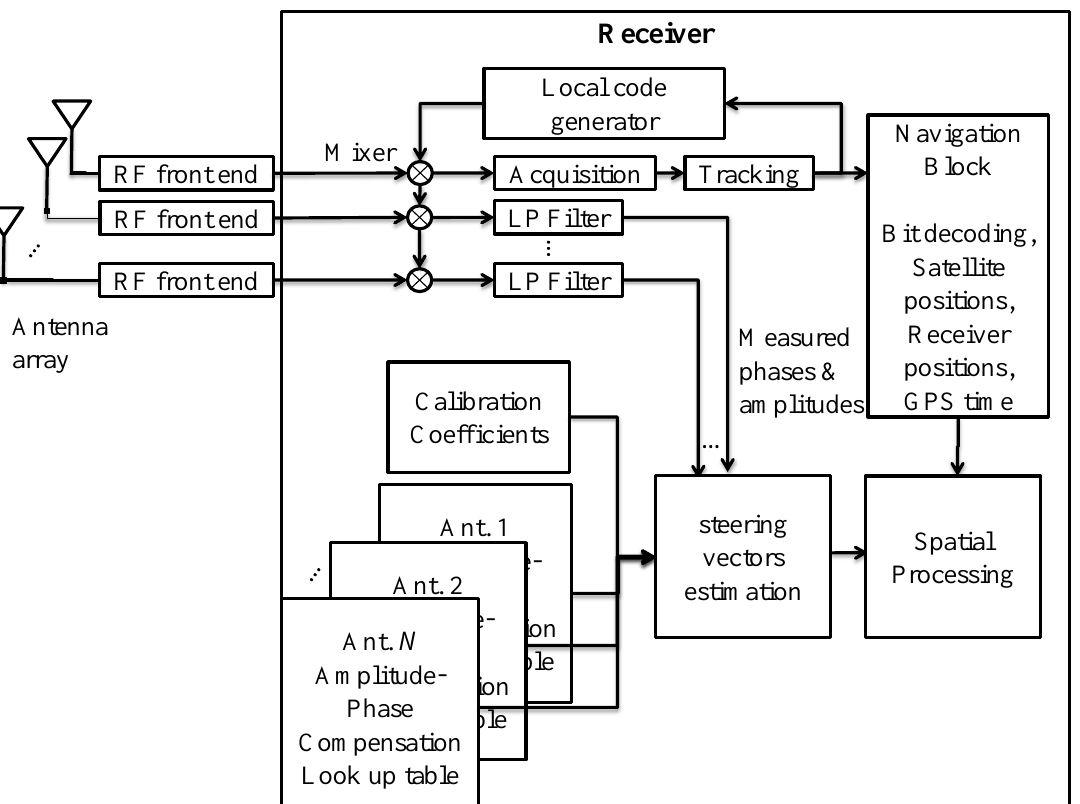
Figure 3. Multi-antenna receiver structure in the operation